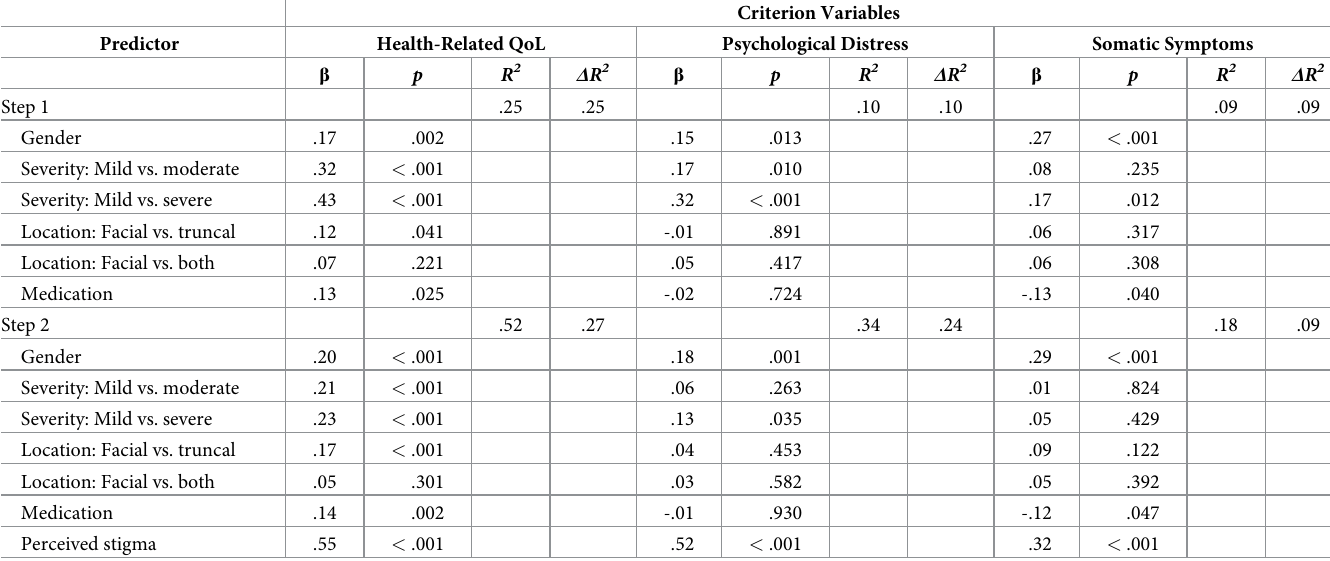
Table 2. Hierarchical regression analyses for variables predicting health-related quality of life, psychological distress, and somatic